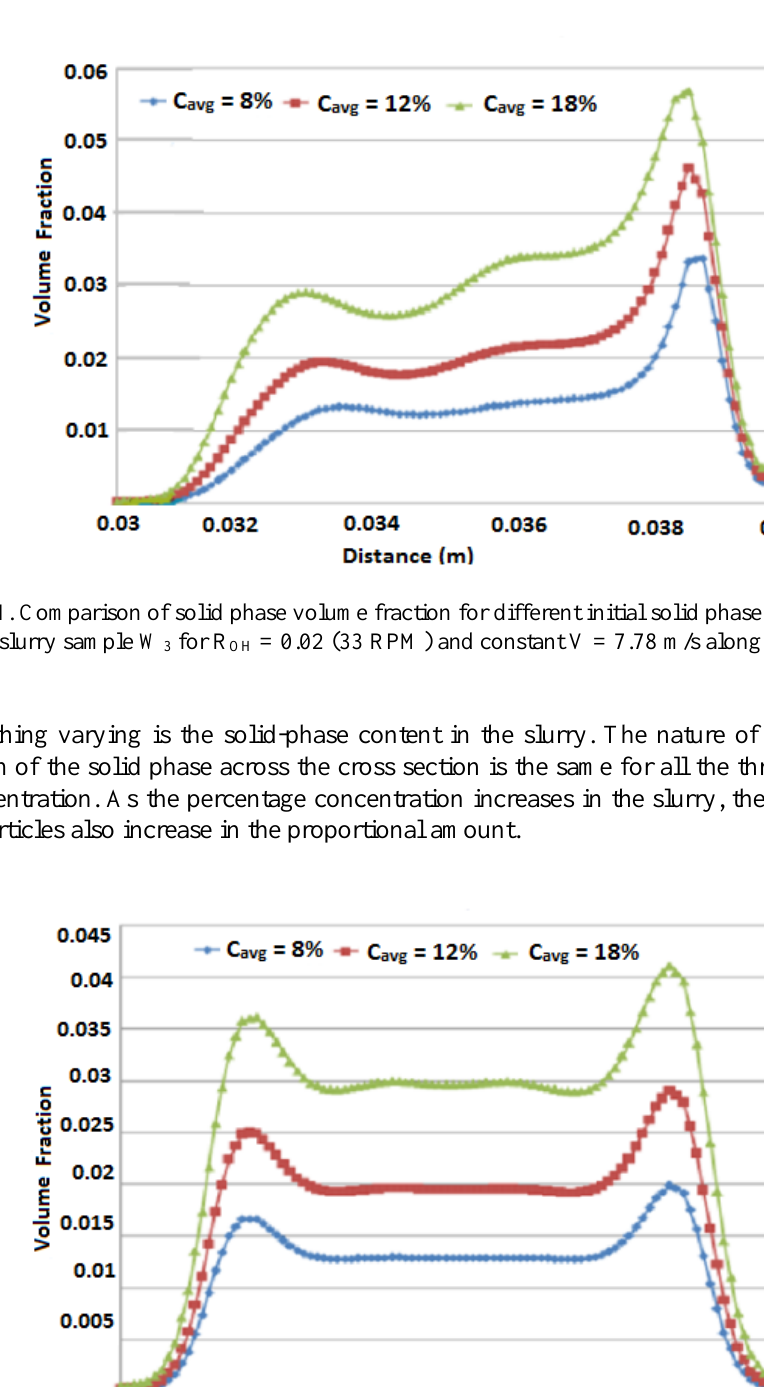
Figure 12. Comparison of solid phase volume fraction for different initial solid phase concentration in slurry sample W3 for R OH = 0.08 (132 RPM) and constant V = 7.78 m/s along Plane